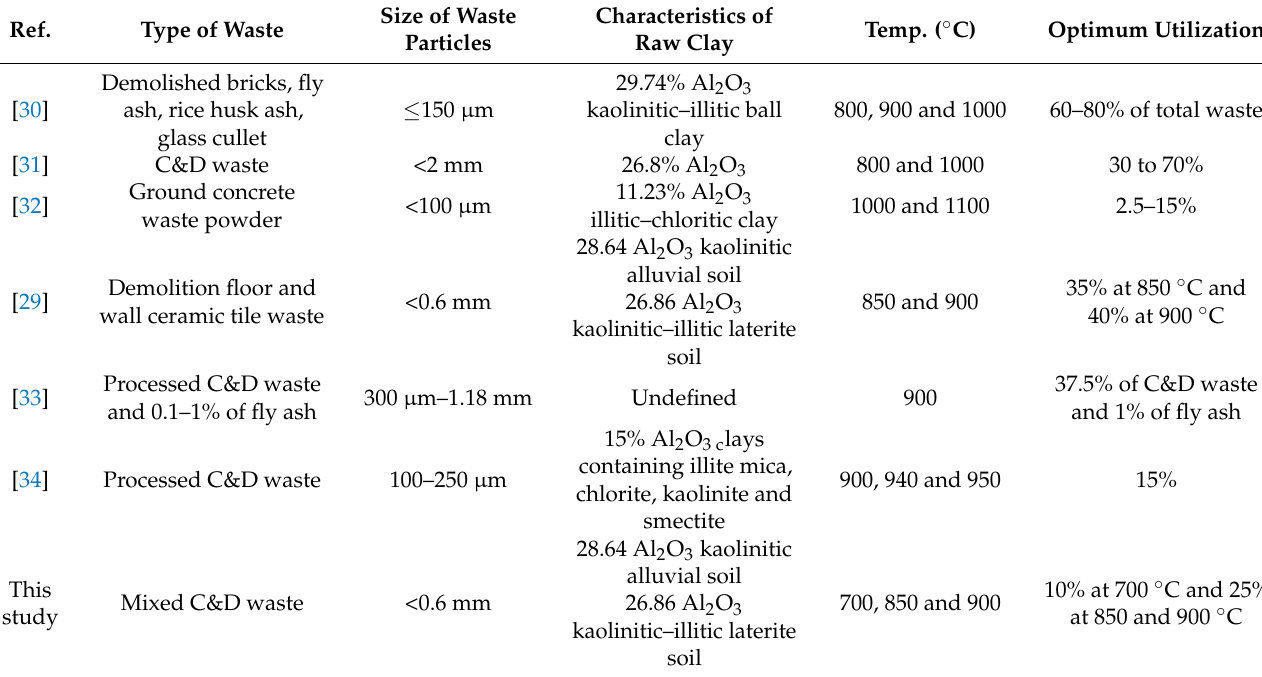
Table 1. Literature analysis on similar waste addition on fired brick production and their key